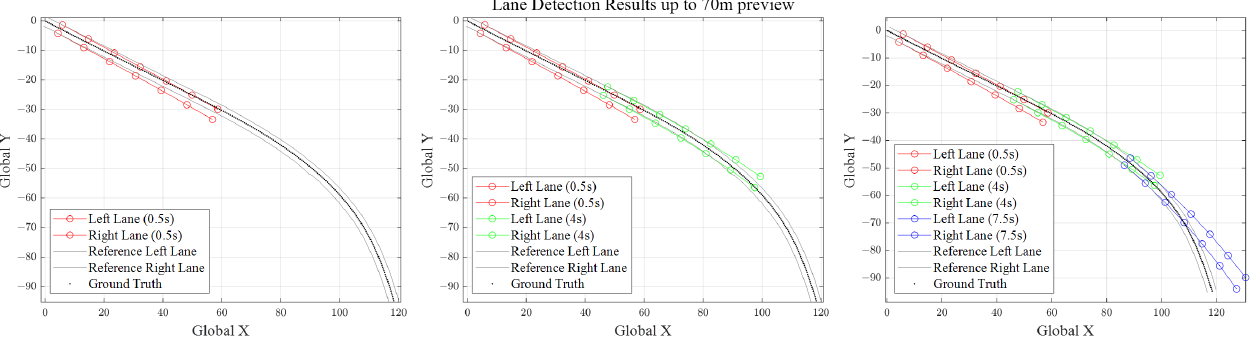
Figure 7. Lane Detection Results (0.5–7.5 s) with 70 m preview